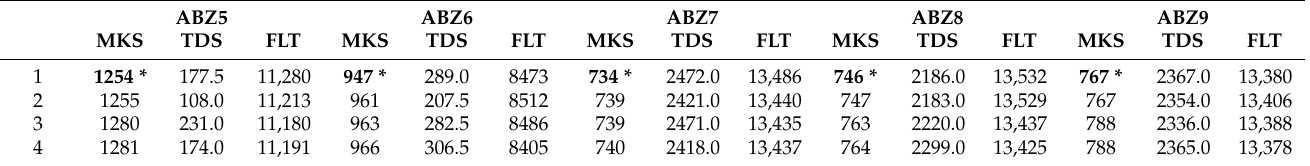
Table A10. Non-dominated solutions obtained by SS/CMOSA for the JSSP instances proposed by